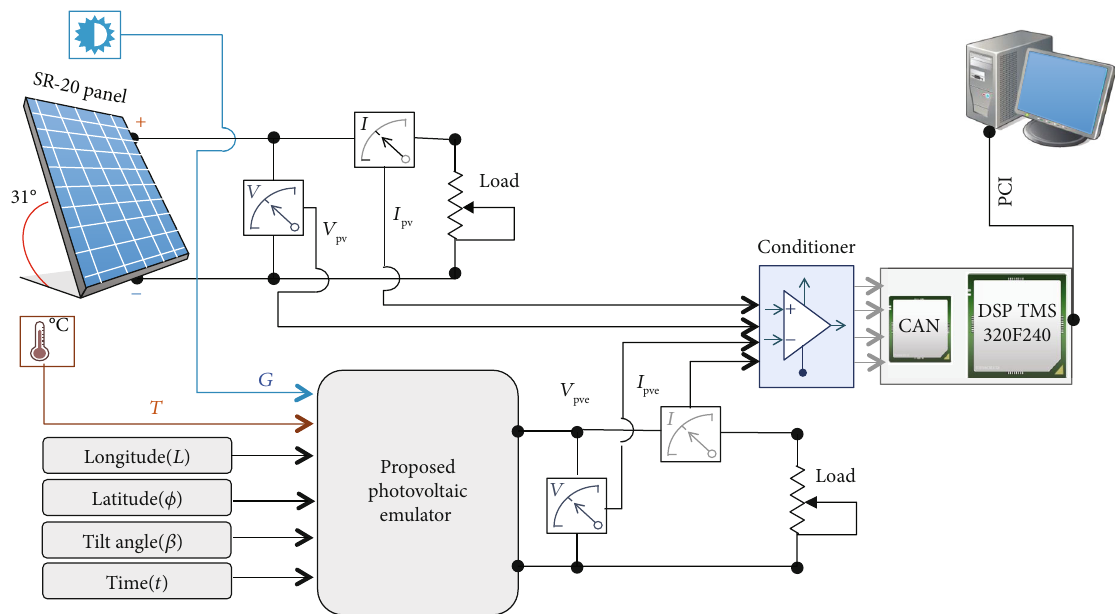
Figure 11: Experimental validation scheme.